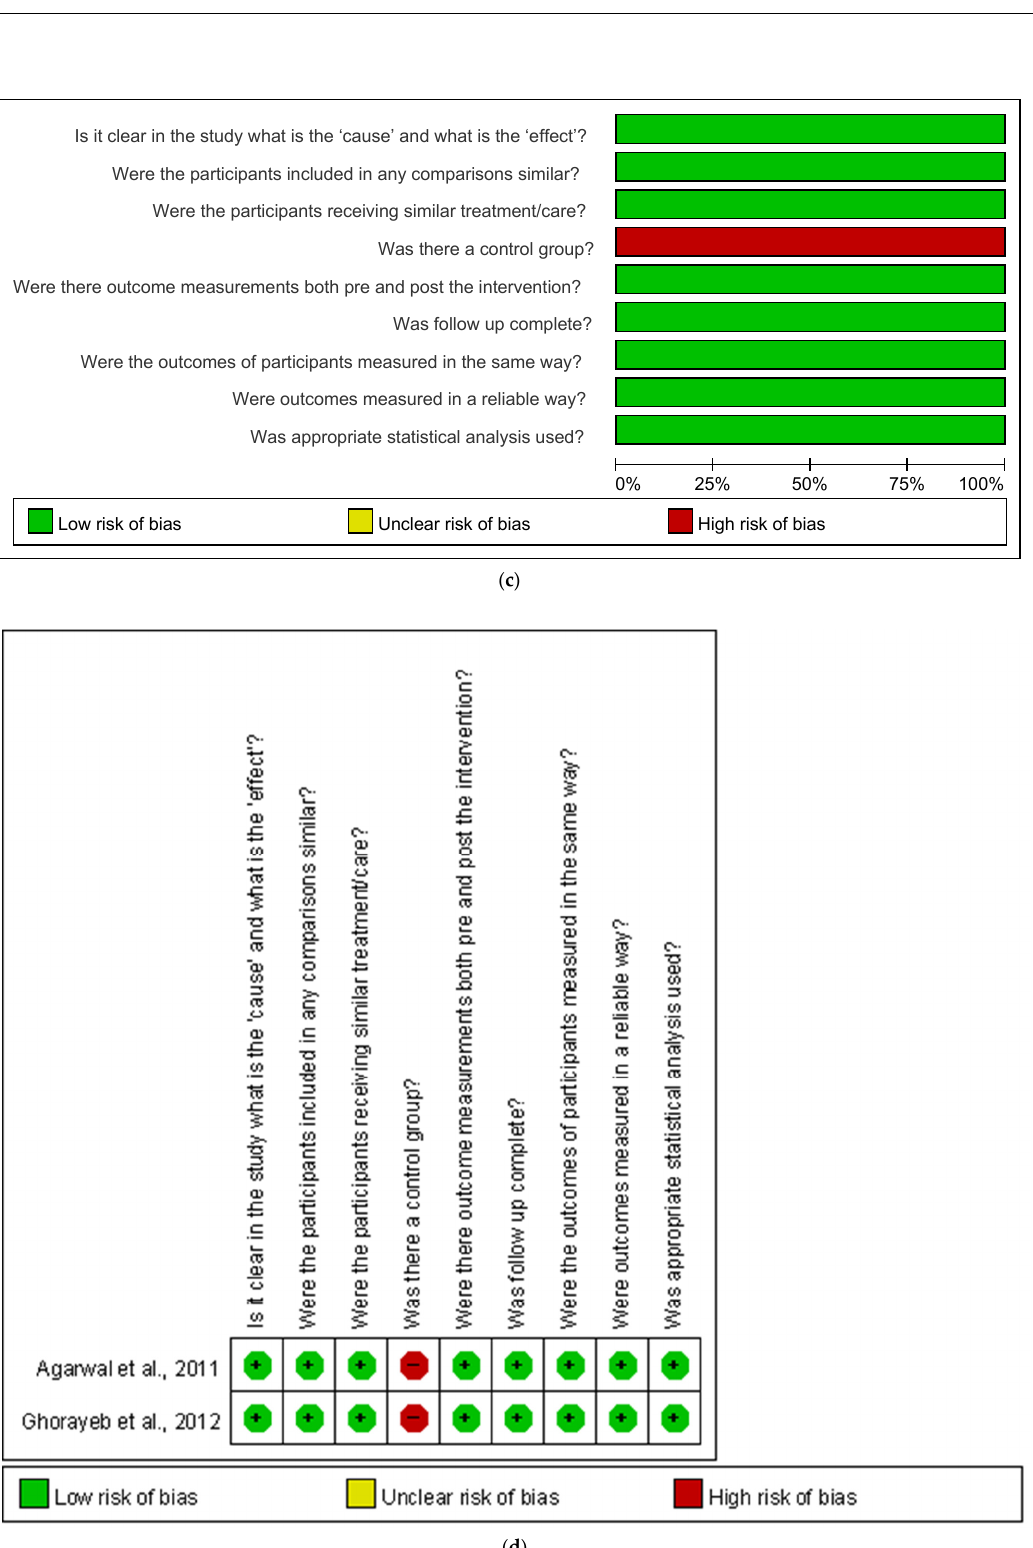
Figure 2. Results of assessments of risk of bias. ( a ) The graph indicates risk of bias of randomized controlled trials, and the questions were from the Cochrane risk of bias tool; ( b ) The table indicates risk of bias of randomized controlled trials, and the questions were from the Cochrane risk of bias tool; ( c ) The graph indicates risk of bias of non-randomized controlled studies, and the questions were from the JBI Critical Appraisal Checklist for Quasi-Experimental Studies; ( d ) The table indicates risk of bias of non-randomized controlled studies, and the questions were from the JBI Critical Appraisal Checklist for Quasi-Experimental Studies.